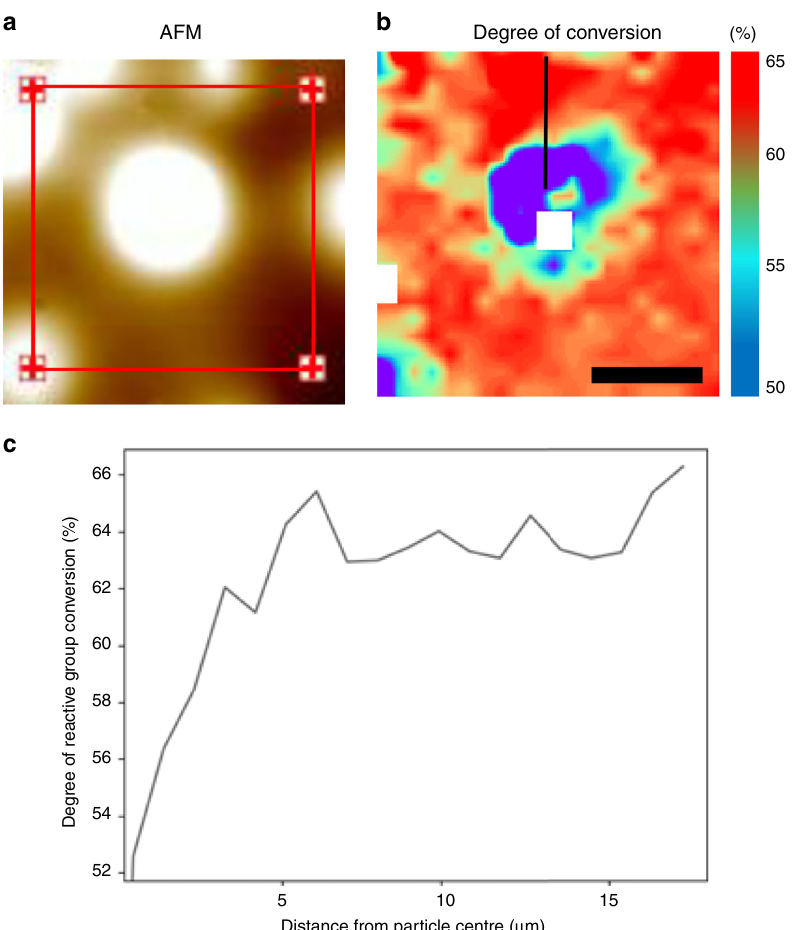
Fig. 3 AFM-IR characterisation of inter-particulate reactive group conversion. a A region of a sample containing silica spheres embedded within a 60/40 wt% (Bis-GMA/TEGDMA) resin matrix initiated with CQ that was imaged using AFM-IR. b Spatial distribution of reactive group conversion over the same region of interest shown in ( a ). Red and blue regions correspond to higher and lower reactive group conversion while white pixels represent spectra which did not pass a quality test. The scale bar is equivalent to 8 µ m. c Line transect, shown in ( b ), of reactive group conversion through the central silica sphere. Deconvolution of representative spectra obtained using AFM-IR are shown in Supplementary Fig. resin matrix. A line transect from the centre of the silica particle into the resin matrix (Fig. 3c) shows a similar pro fi le to other CQ